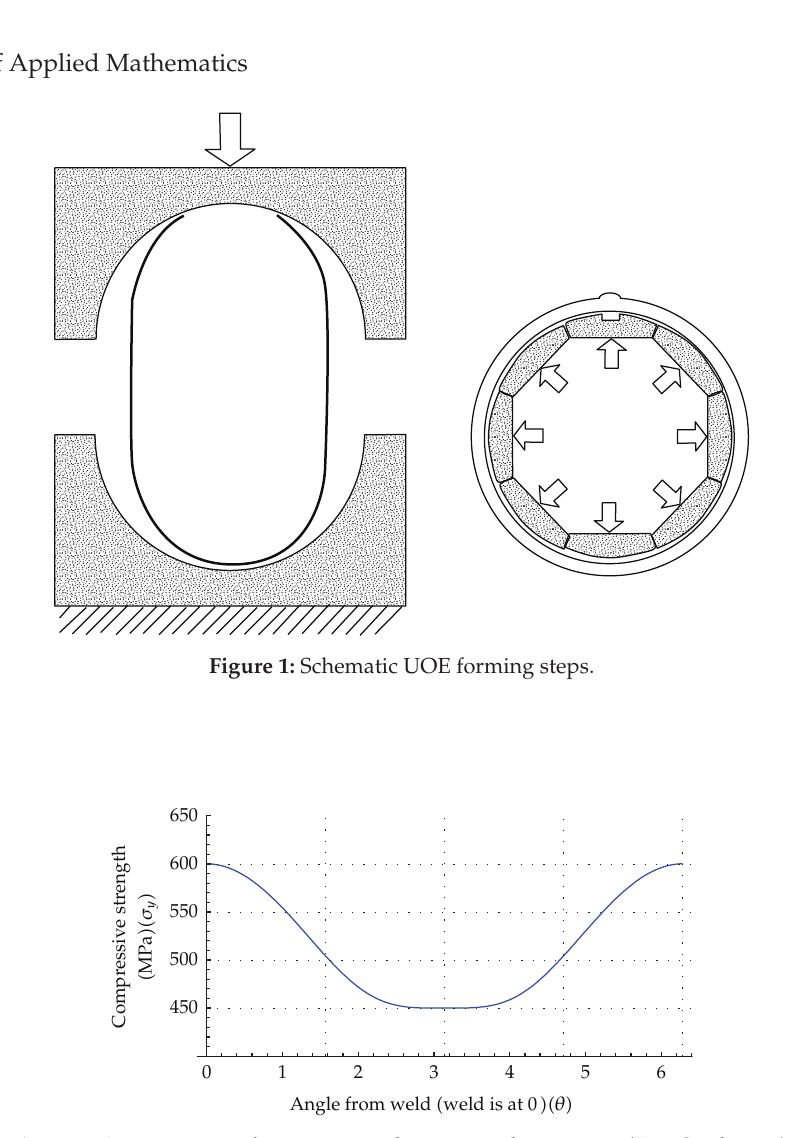
Figure 2: Average strength variation with pipe angular position (cid:6) Tata Steel, 2010 (cid:7)